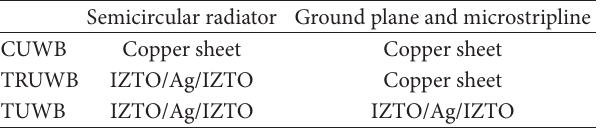
Table 1: Composition of proposed antennas.